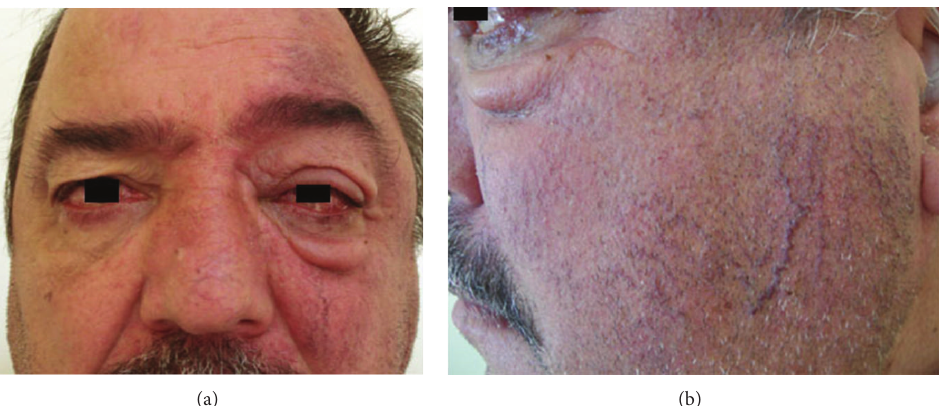
Figure 1: Patient with conjunctival chemosis, edema of the eyelid, dilatation of the conjunctival and episcleral vessels, and more visible superficial skin vessels on the left side of the face.